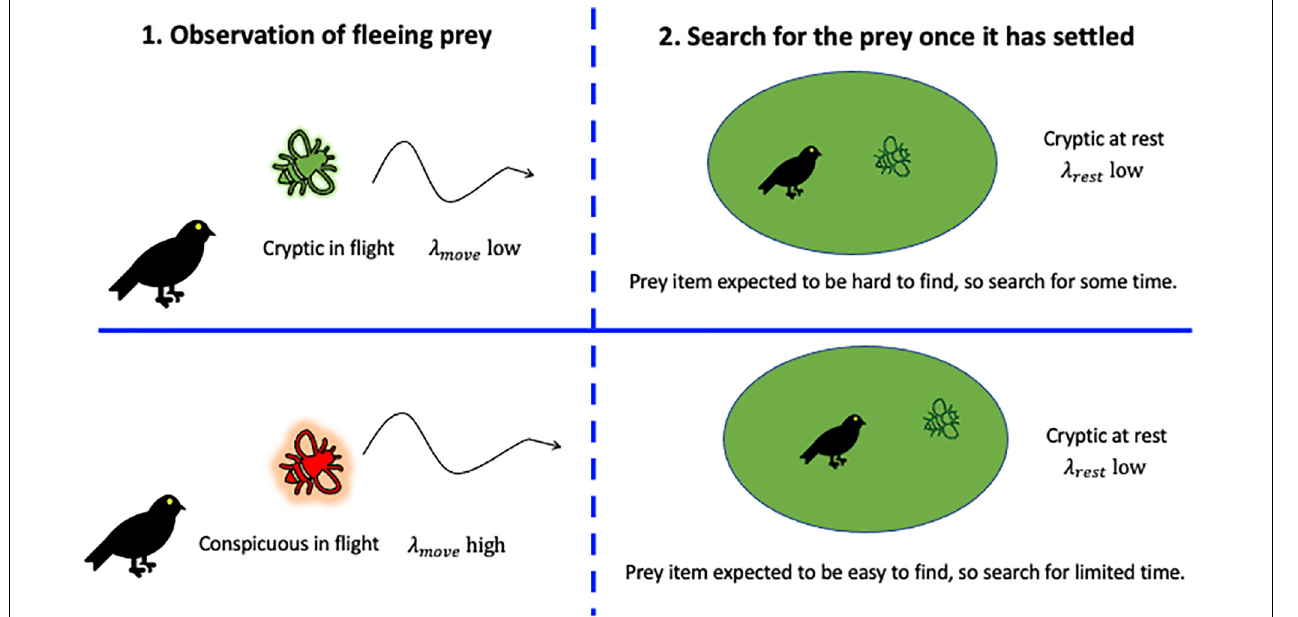
FIGURE 2 | A visual depiction of how flash behavior when fleeing prey might interfere with the search process of predators. Predators that encounter a prey item that is perceived as conspicuous when it flees may expect to readily find the prey when they start to search for it. If the prey item is not quickly found, then the predator will soon cease searching, believing the prey to be elsewhere. Flash behavior may therefore work by deceit, causing predators to adopt an inappropriately short search time for the prey in any given location. The infographic uses stock images from Microsoft PowerPoint